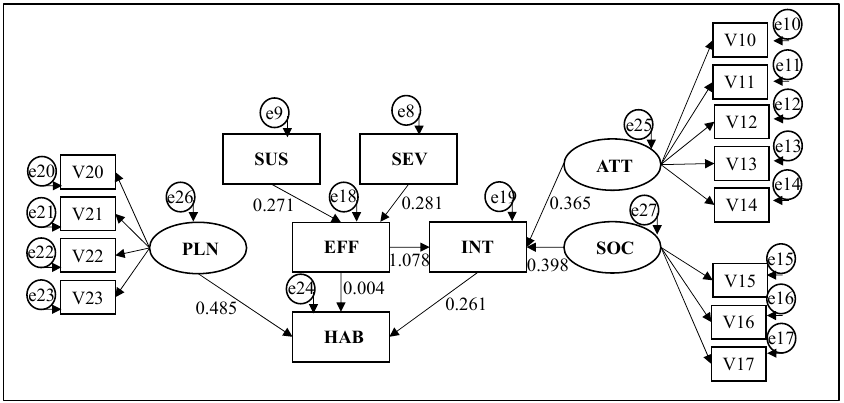
Figure 2. SEM specification for the UV textile usage.